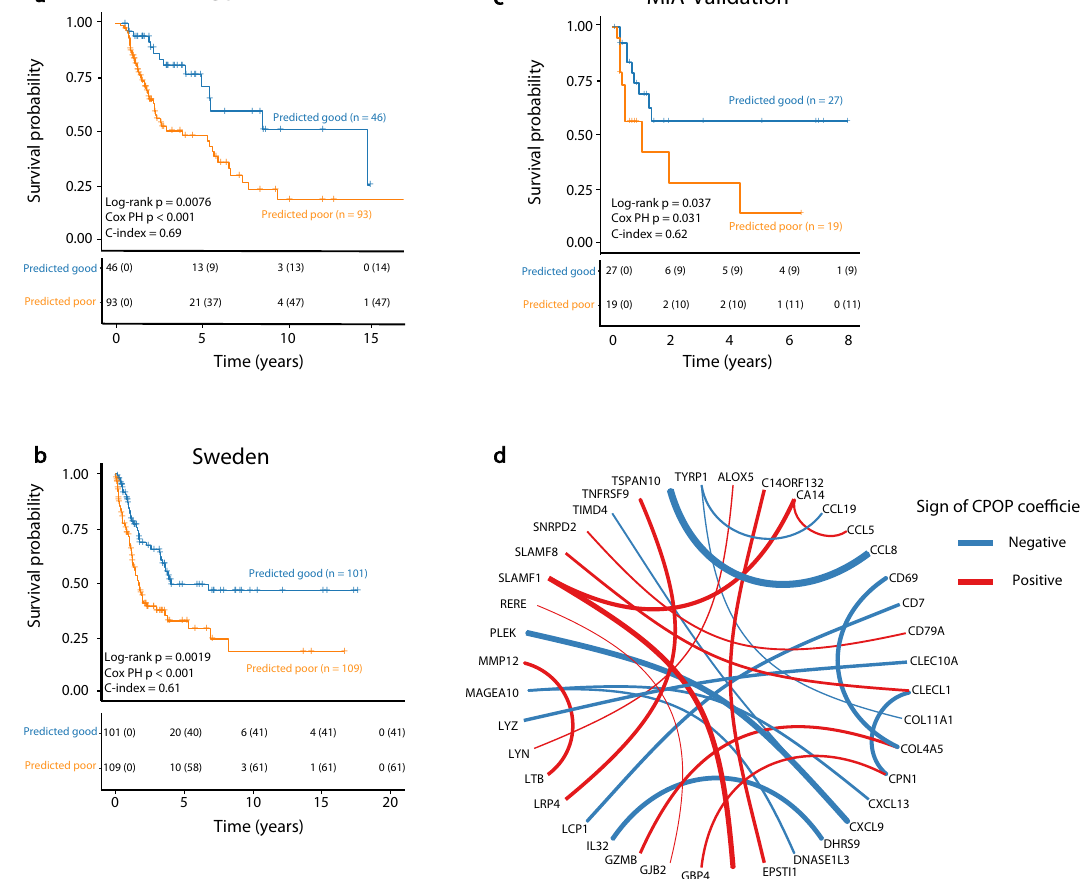
Fig. 3 Validation results of the melanoma dataset. a Kaplan – Meier plots show a signi fi cant difference in survival probability between the predicted good (blue line) and poor (orange line) prognostic classes on the TCGA ( n = 139). The CPOP model here is trained on MIA- Microarray and MIA-NanoString based on the RFS-de fi ned prognosis classes. b Similar evaluation for the Sweden ( n = 210) data. c Similar evaluation for the MIA-Validation data ( n = 46) (including four imputed genes). d Network visualisation of the fi nal CPOP model highlights the ratio-based signatures developed from applying the CPOP model on the MIA-Microarray and MIA-NanoString data. Each node of the network represents a gene and an edge connecting two genes (nodes) represents the log-ratio feature that is present in the signature. The colour and thickness of each edge represent the sign and the magnitude of the size of the estimated coef fi cients, respectively. The genes are in alpha- numeric and poor predicted classes in Fig. 3c ( p = 0.037). CPOP demon- Supplementary Table 4. In this fi gure, an edge connecting two genes (nodes) indicates the ratio is present in the CPOP signature and its thickness indicates the magnitude of coef fi cient values in the predictive model and their direction of correlation, respec- tively. Genes most strongly implicated include CXCL9 18,19 , CCL8 20 , TSPAN10, PLEK, CLEC10A 21 , SLAMF1, CLECL1, MAGEA10, CXCL13